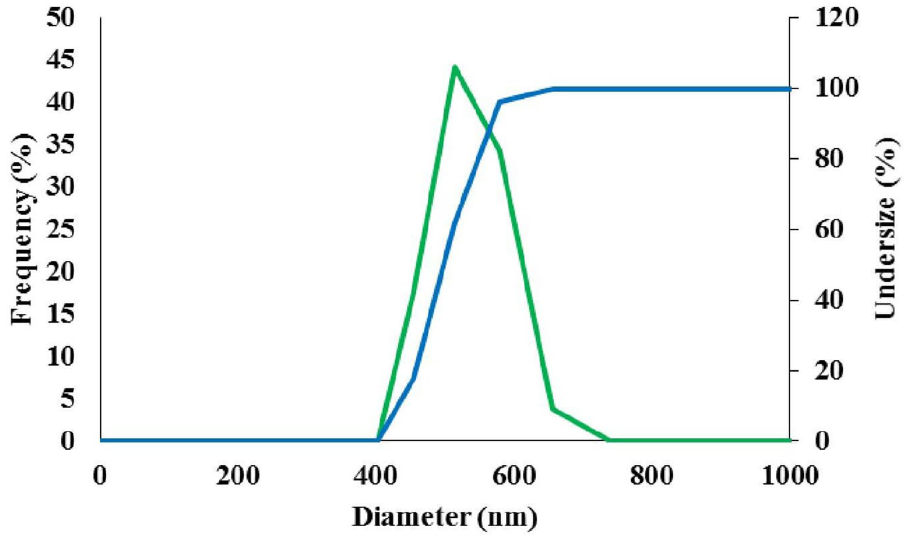
Figure 7. DLS histogram of hybrid by 1,2-phenylenediamine and terephthaloyl chloride on the magnetic